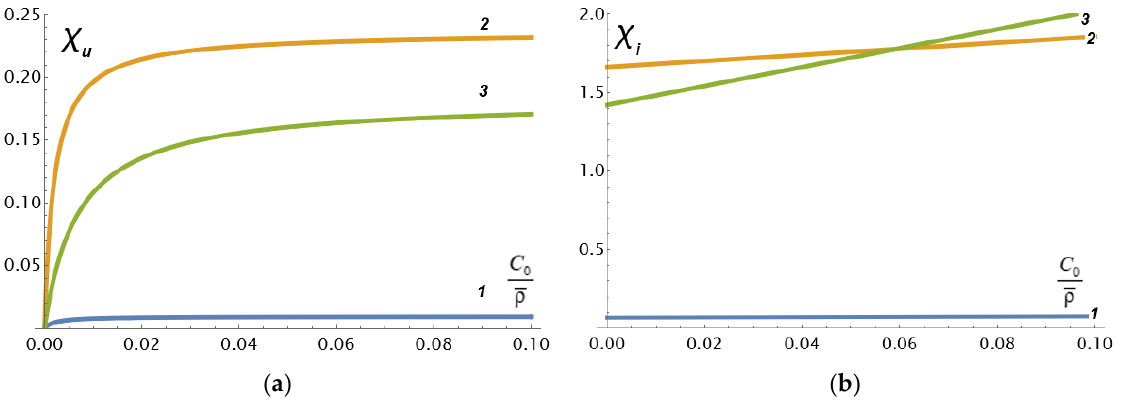
Figure 2. Dependencies of dimensionless coefficients χ u ( a ) and χ i ( b ) as functions of relative concentration C 0 ρ of HCl electrolyte: m 0 = 9.6%, s 0 = 1 (1); m 0 = 9.6%, s 0 = 5 (2); m 0 = 30%, s 0 = 5 (3);